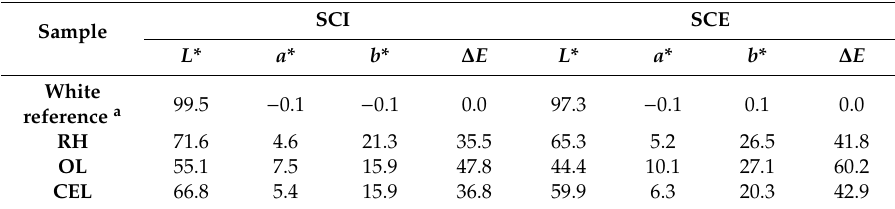
Table 2. Color coordinates and color di ff erences of RH (rice husks), OL (organosolv lignin), and CEL (cellulolytic enzyme lignin).